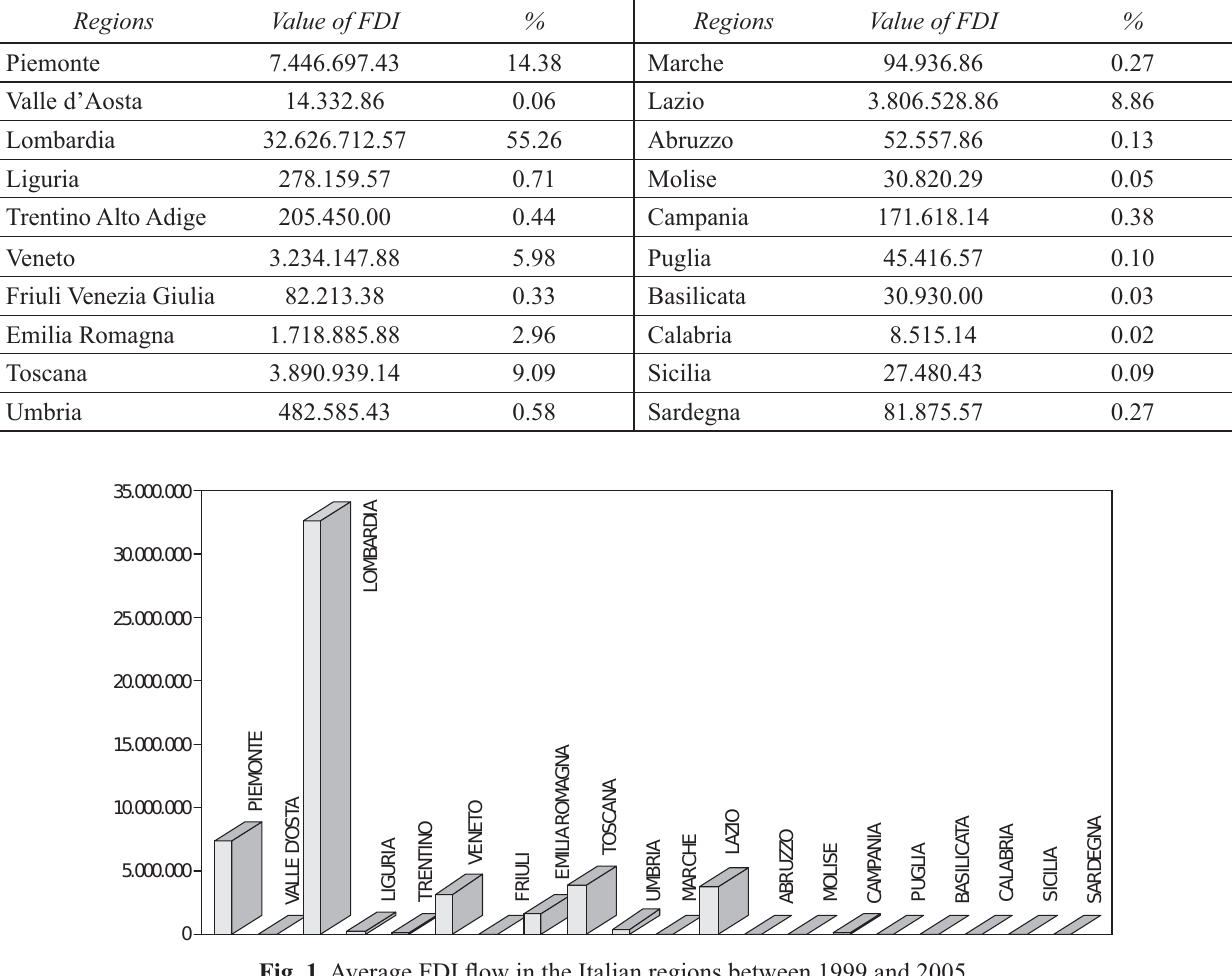
Fig. 1. Average FDI fl ow in the Italian regions between 1999 and 2005 Table 2. FDI infl ow per macro-area between 1999 and